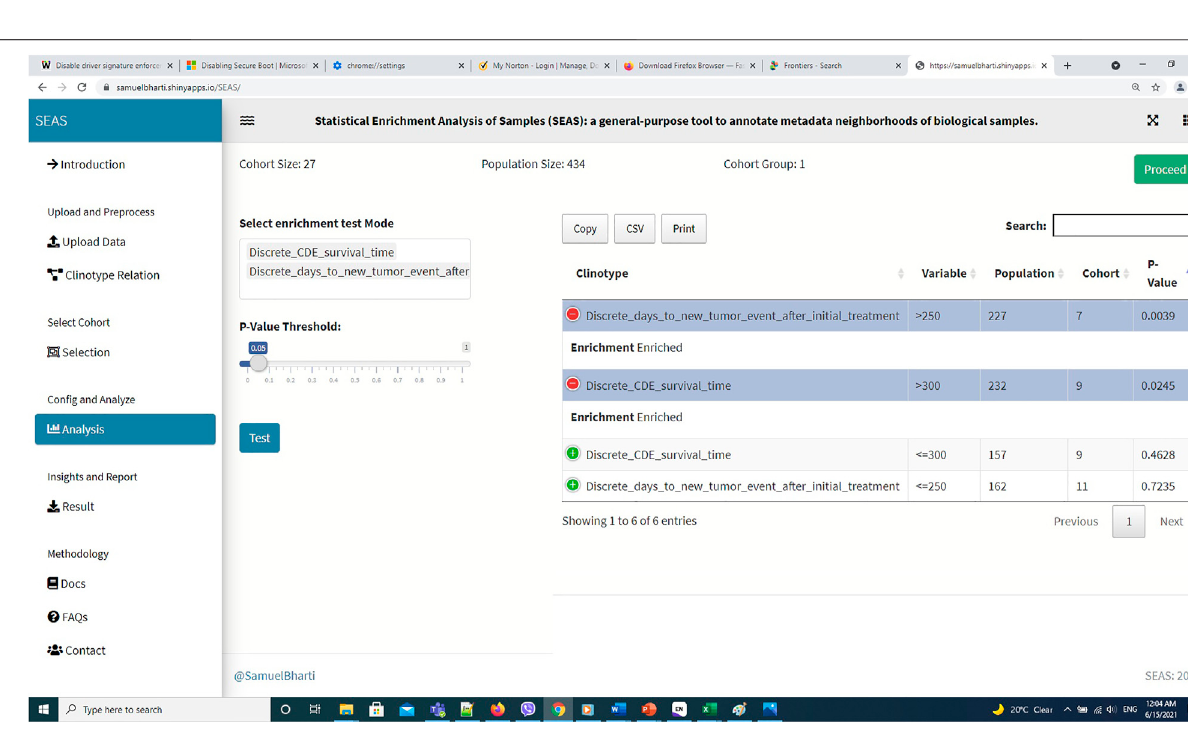
Frontiers in Big Data |